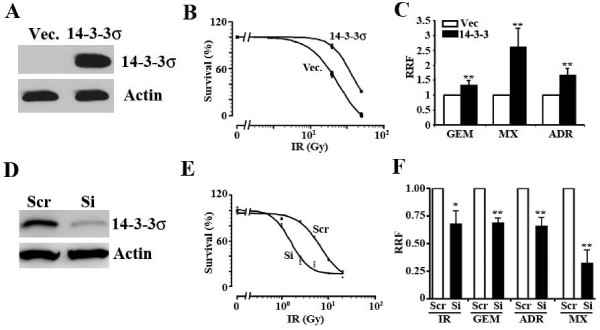
14-3-3σ over-expression causes resistance to γ-irradiation and anticancer drugs in pancreatic cancer cell lines. A, Western blot analysis. Lysates from MiaPaCa-2 cells stably transfected with 14-3-3σ or vector control were prepared for Western blot analyses of 14-3-3σ and actin as a control. B, Effect of 14-3-3σ over-expression on radiation resistance. Clonogenic assay was used to determine the response of MiaPaCa-2 stable clones transfected with 14-3-3σ or vector control (Vec.) to γ-irradiation (IR). C, Effect of 14-3-3σ over-expression on drug resistance. SRB assay was used to determine the response of MiaPaCa-2 stable clones transfected with 14-3-3σ or vector control (Vec.) to anticancer drugs gemcitabine (GEM), mitoxantrone (MX), and Adriamycin (Adr). RRF = relative resistance factor derived by dividing the IC50 of 14-3-3σ-expressing cells by that of the vector-transfected control cells. D, Western blot analysis. Lysates from BxPc-3 cells stably transfected with 14-3-3σ or scrambled shRNA control were prepared for Western blot analyses of 14-3-3σ and actin as a control. E and F, Effect of 14-3-3σ knockdown on treatment resistance. SRB assay was used to determine the response of BxPc-3 stable clone transfected with 14-3-3σ or scrambled (Scr) shRNA control to γ-irradiation and anticancer drugs. RRF = relative resistance factor derived by dividing the IC50 of 14-3-3σ-knockdown cells by that of the scrambled control cells. (* = p value < 0.05; ** = p value < 0.01).